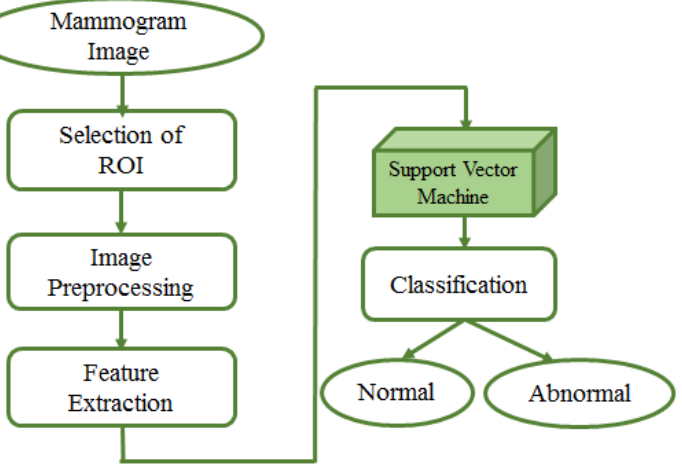
Figure 8. Mammogram image analysis by SVM. Input to the model is the mammogram image. Fixed-size region of interest (ROI) patches are extracted from mammogram images; pre-processing is done on extracted patches to improve the quality. Afterwards, a feature extraction step is needed to ingest SVM to train a model for classification of patches as benign or